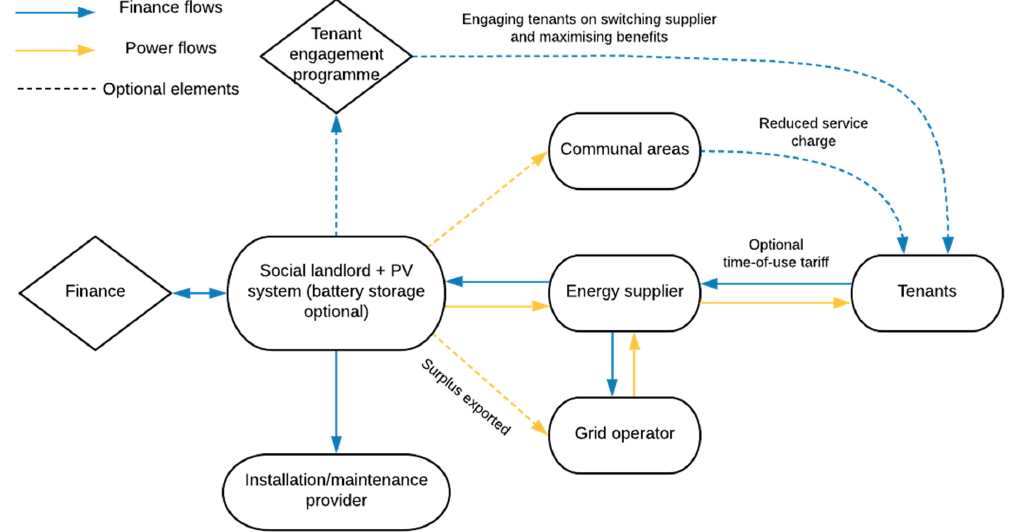
Figure 1. ‘Local’ flowchart, adapted from ‘Figure 15: Typical self-consumption business model’ in Dunlop and Roesch [45]. Additions of tenant engagement, powering communal areas and time-of- use tariffs derived from interview and workshop data. tari ff s derived from interview and workshop